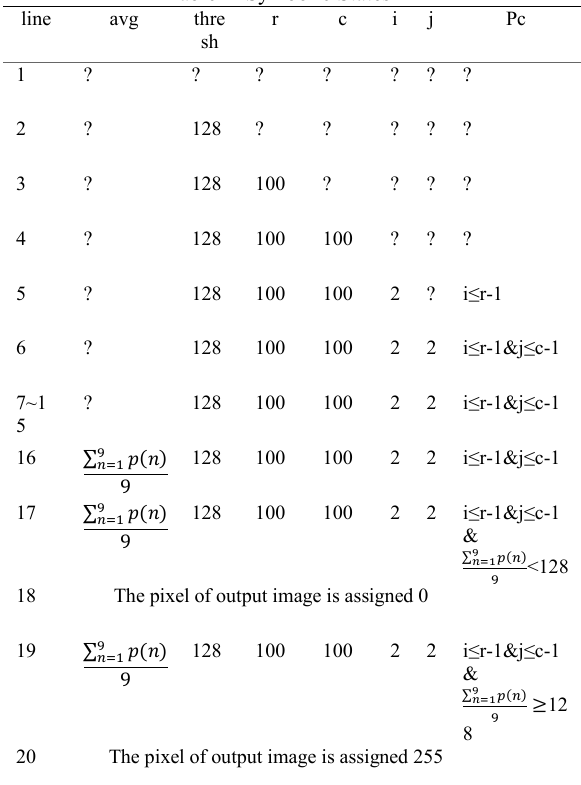
Table 1 Symbolic